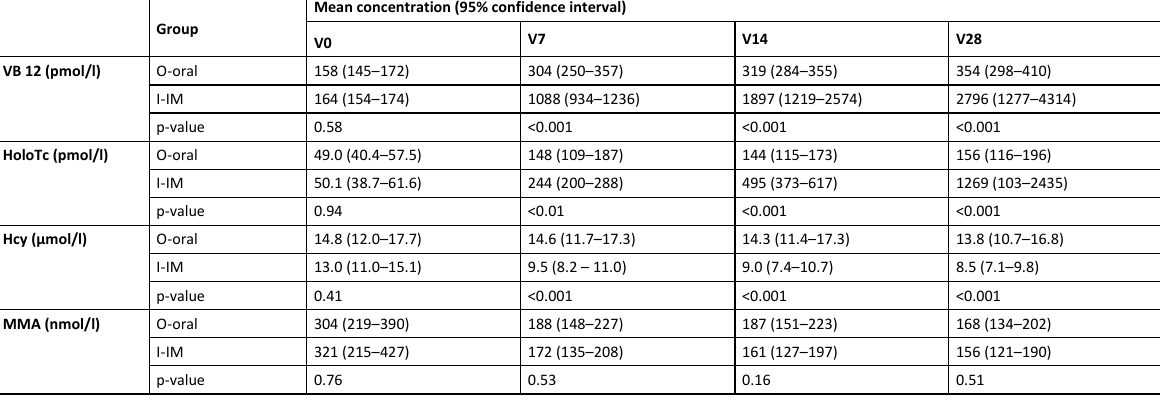
Table 2: Serum concentrations of vitamin B 12 , holotranscobalamin, homocysteine and methylmalonic acid at baseline (V0) and after 7, 14 and 28 days of treatment (V7, V14 and V28).